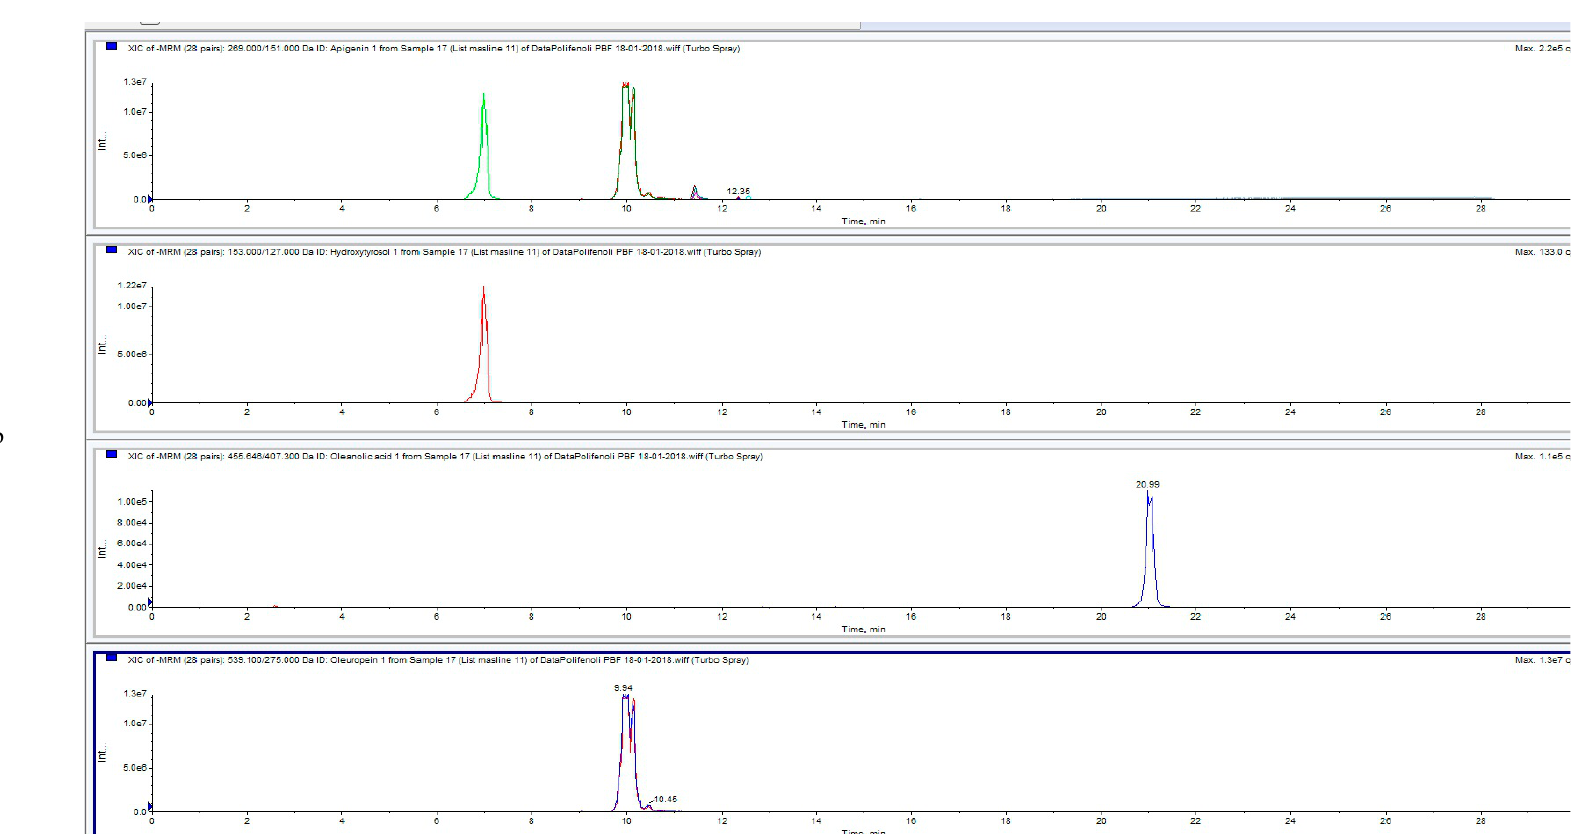
Figure 2. ( a ) UPLC-MS/MS analysis chromatogram of untreated OLE (3 OL50)—total ion current (TIC). ( b ) UPLC-MS/MS analysis chromatogram of untreated OLE (3 OL50 ).